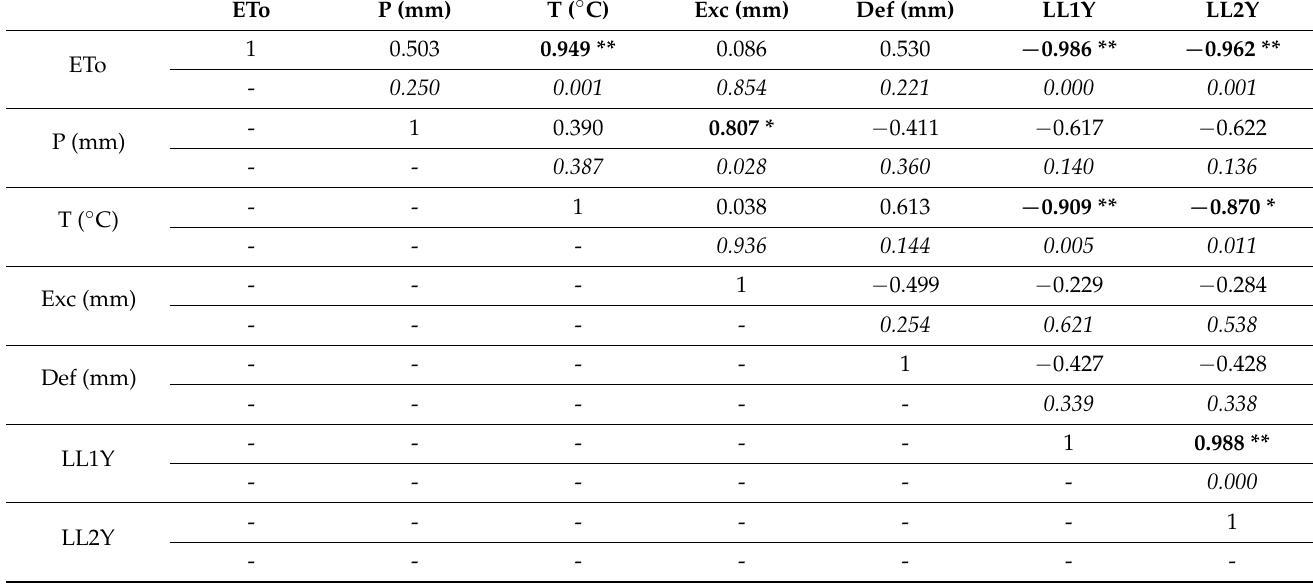
Table 1. Correlation matrix of the environmental factors and lesion lengths on walnut branches; ETo—potential evapotran- spiration, P (mm) -precipitations, T ( ◦ C)—average temperature, Exc (mm)—excess of precipitations above climatic normal, Def (mm)—rainfall deficiency below climatic normal, LL1Y—lesion length on 1-year branches and LL2Y—lesion length on 2-year branches; correlation is significant at the 0.01 2-tailed level ( ** ) and 0.05 ( * ); σ is highlighted in italic fonts; statistically significant correlations were highlighted in bold